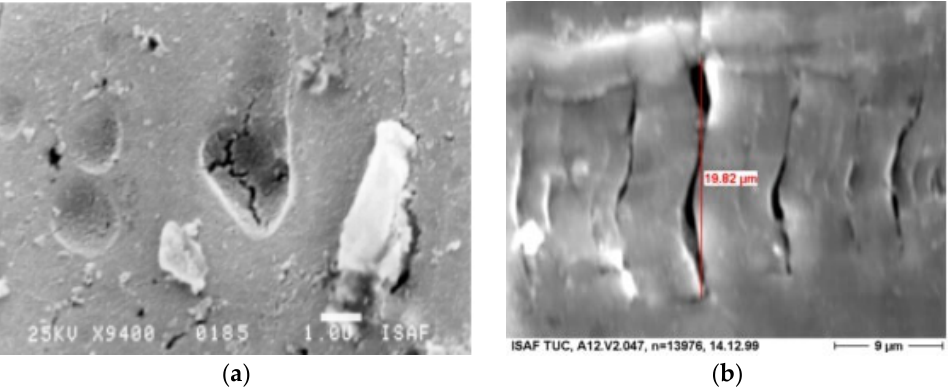
Figure 13. SEM image of the surface of the test object due to torsion load, γ a = 0.55%, N = 13,976. ( a ) crack initiation starting from the position of the particles; ( b ) torsion cracks.